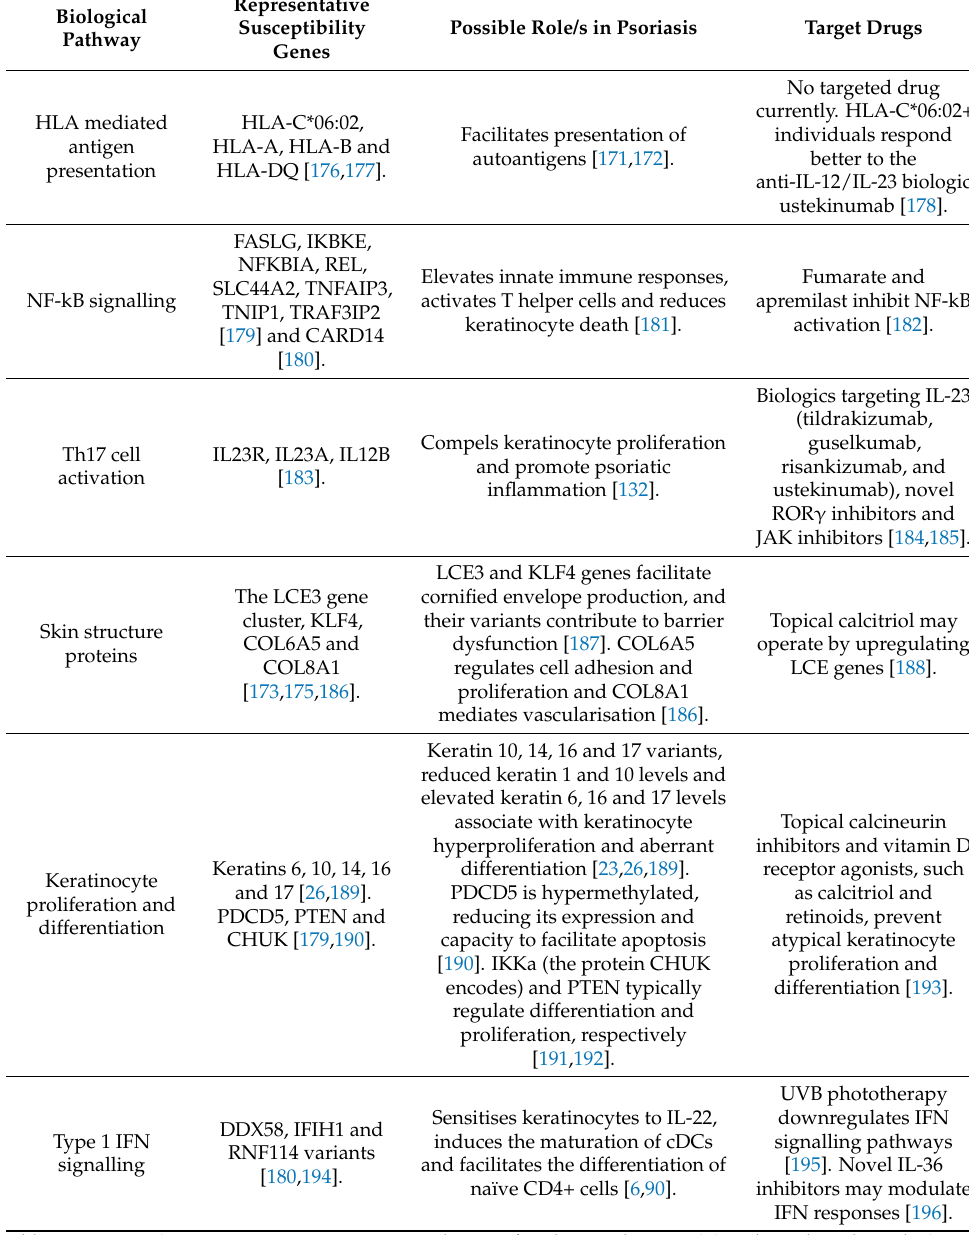
Table 2. Key pathways to which psoriasis genetic susceptibility factors